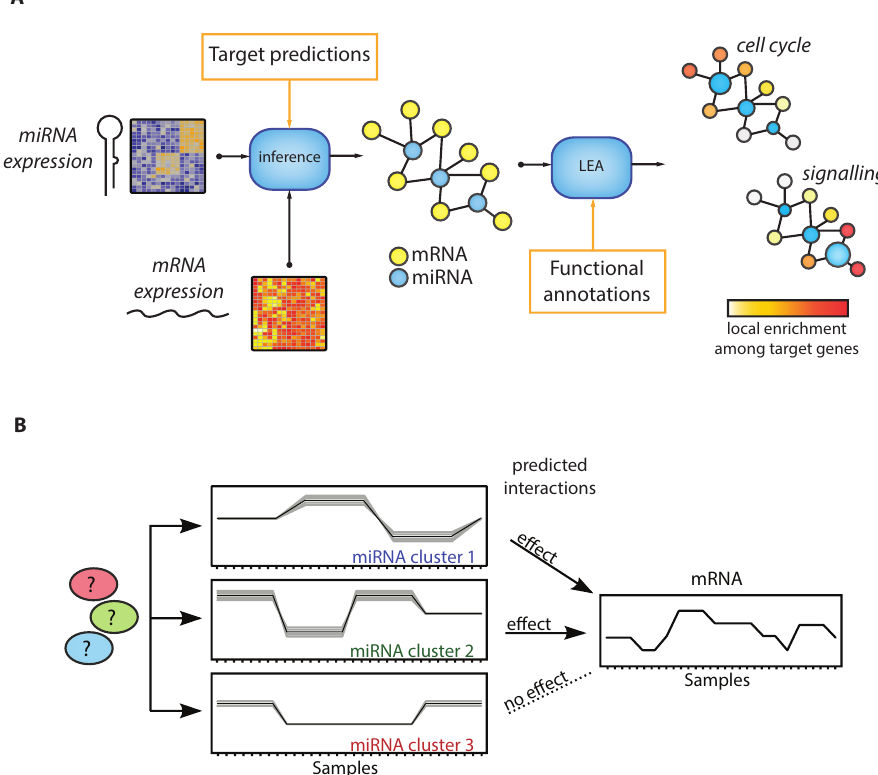
Figure 1. Functional characterization of miRNAs in a condition-specific manner by data-driven inference of mi-/mRNA networks and subsequent functional annotation in the